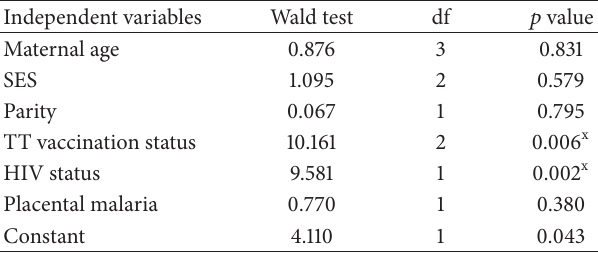
Table 2: Logistic regression analysis results exploring the predictive significance of maternal factors on maternal tetanus antibody serostatus.